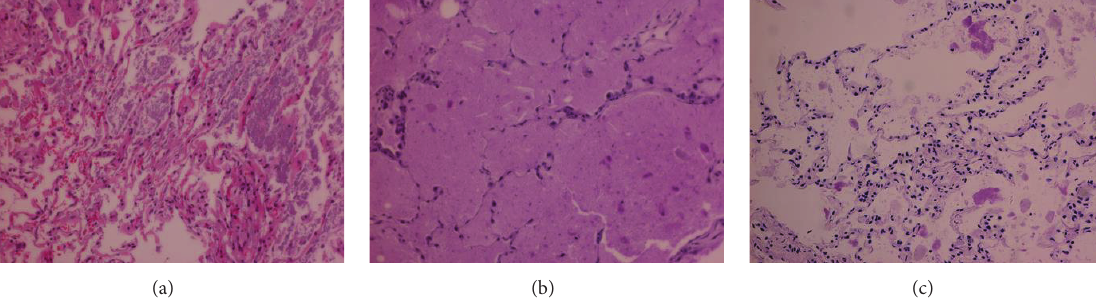
Figure 3: Samples obtained via video-assisted thoracoscopic biopsy after initiation of everolimus therapy. (a) Pink granular material filling the airspaces, hematoxylin and eosin stain. (b) Scattered amorphous solid eosinophilic globules, periodic acid-Schiff (PAS) stain. (c) Diastase- resistant eosinophilic globular inclusions, PAS stain with diastase.